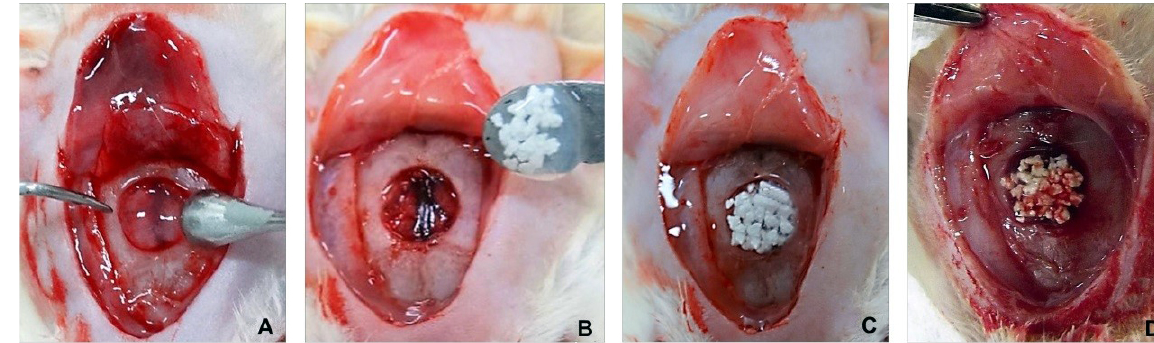
Figure 5. Critical-size defects in rat calvarial bones: (A) bioadhesion of the fibrin biopolymer at the edges of the surgical bone cavity; (B) osteotomy in the center of the parietal bones and agglutination of the bone graft particles by the fibrin biopolymer before deposition; (C and D) deposition of the fibrin biopolymer mixture with different bone grafts in the surgical